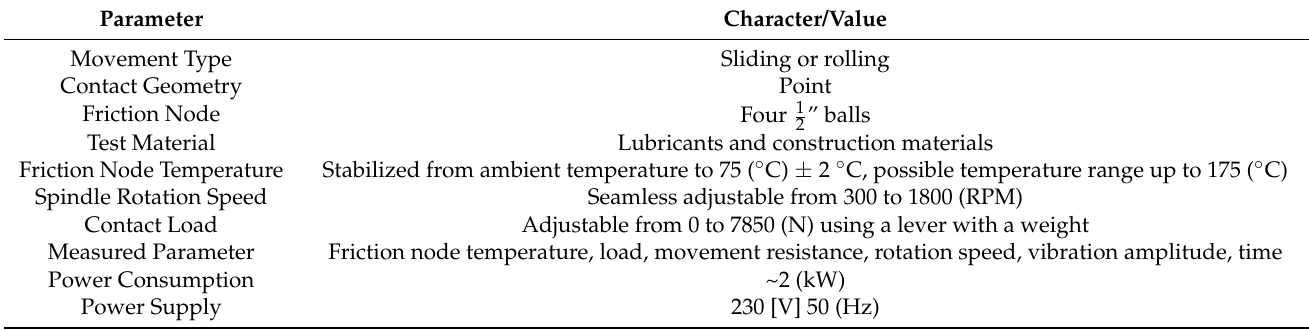
Figure 2. T02U I Silesia four-ball tester, ( a ) picture of the measuring device, ( b ) diagram of a four-ball friction node (1, top ball; 2, bottom balls; 3, 4, holders) [21]. Table 1. T02U tester